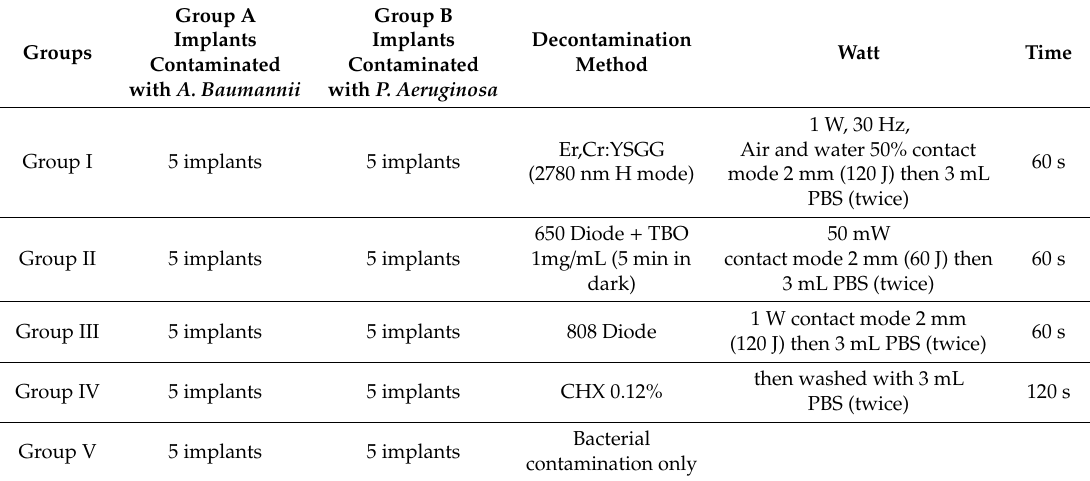
Table 1. Experimental groups and treatment modalities used in the